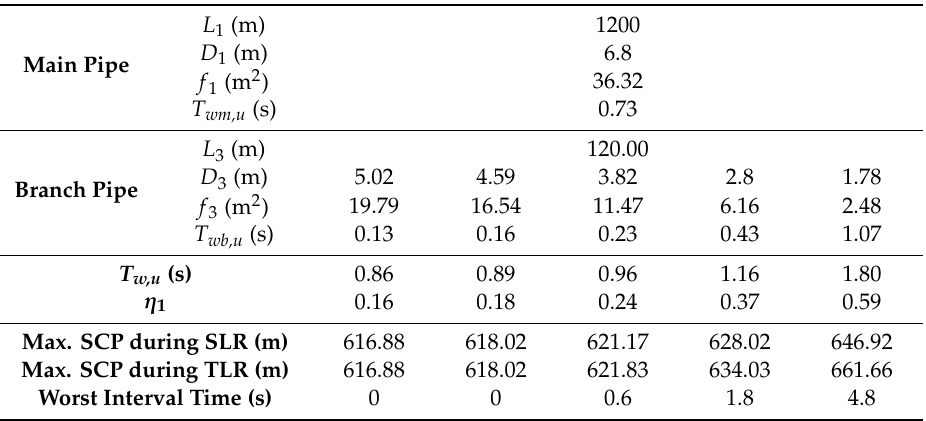
Table 4. Conduits parameters and corresponding results for Scenario 2.